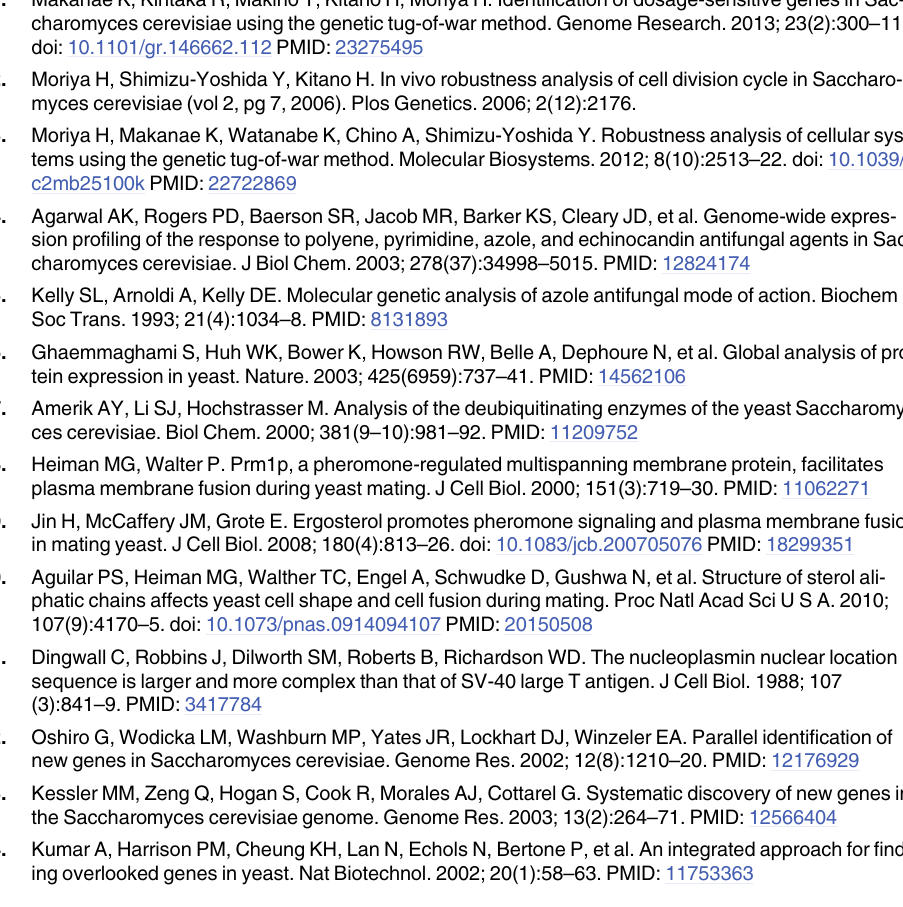
S3 Fig. Predicted helical structure in sORF2. The 3D structures, summaries, and alignments are shown. The images were snapshots of displayed on the Phyre2 website (http://www. sbg.bio.ic.ac.uk/phyre2/). S4 Fig. Isolation of genes whose expressions were significantly changed upon increase in DIE2-Rear2 fragment. We first isolated genes showing significant difference (FDR < 0.5) be- tween; pTOWug2 – 836 and pTOWug2-Rear2 (Comp1), pTOW40836 and pTOWug2-Rear2 (Comp2), pTOWug2 – 836 and pTOW40836 (Comp3), and between pTOWug2-Rear2 dupli- cates (Comp4). We then made a gene list, which contained true positives, from isolated genes in Comp1 or Comp2, but neither in Comp3 nor Comp4 (see the Venn